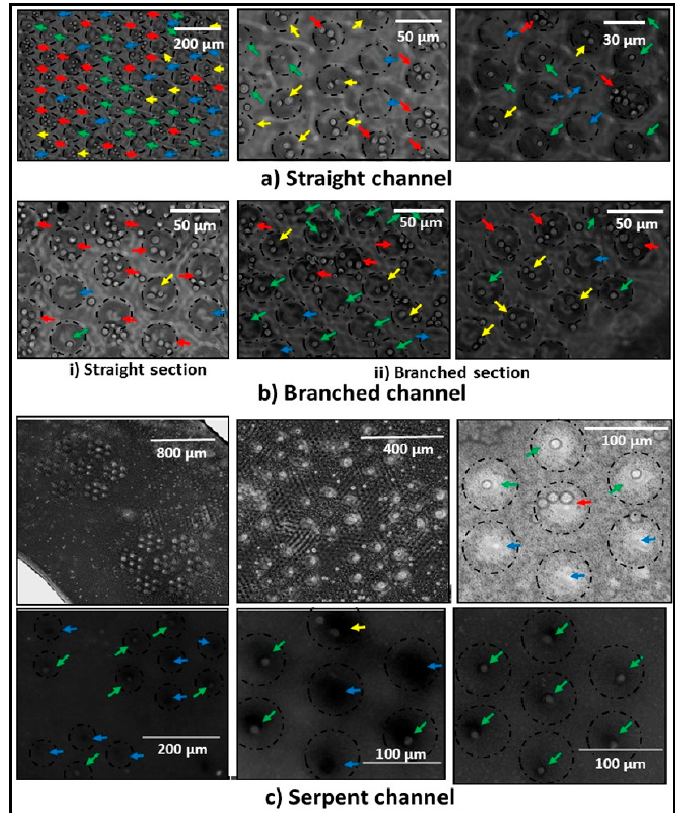
Figure 9. Trapped A549 cells in ( a ) the straight channel design; ( b - i ) the straight section in the branched channel design; ( b - ii ) the side-branched section in the branched channel design, and ( c ) serpent channel design. The blue arrow points to no capture, the green arrow points to SCC, the yellow arrow points to dual-cell capture, and the red arrow points to three or more cell captures. The dotted black circles were just for clarity; it did not resemble the exact scale of the biochip.